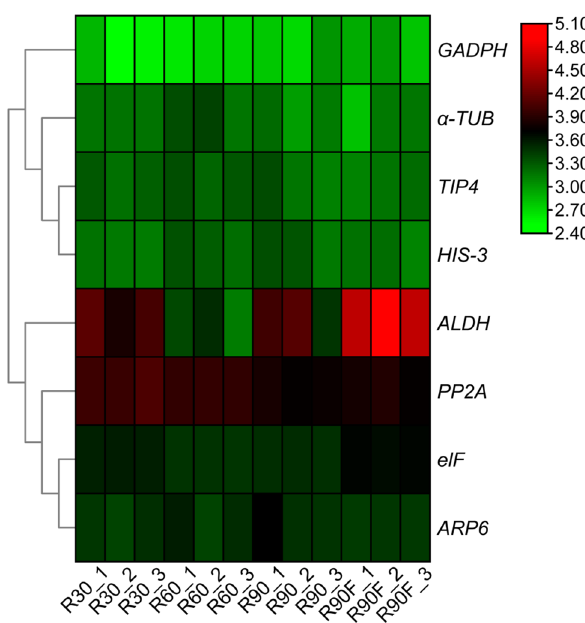
Figure 1. Heatmap of eight candidate reference genes based on Fragments per Kilobase of exon model per Million mapped reads (FPKM) value of transcriptome of rhizosheath development. R30, R60, R90, and R90F indicate the tissues of 30-, 60-, and 90-DPG rhizosheaths and 90-DPG rhizosheath-free roots, respectively. The screening conditions were q-value ≥ 0.05, FPKM ≥ 6, and |log 2 FoldChange| < 1. The eight candidate genes were glycolide-3-phosphate dehydrogenase ( GAPDH ), aldehyde dehydrogenase ( ALDH ), eukaryotic translation initiation factor ( elF ), actin related protein ( ARP6 ), tonoplast intrinsic protein , ( TIP41 ), α-Tubulin ( α-TUB ), protein phosphotase 2A ( PP2A ), and Histone H3 ( HIS-3